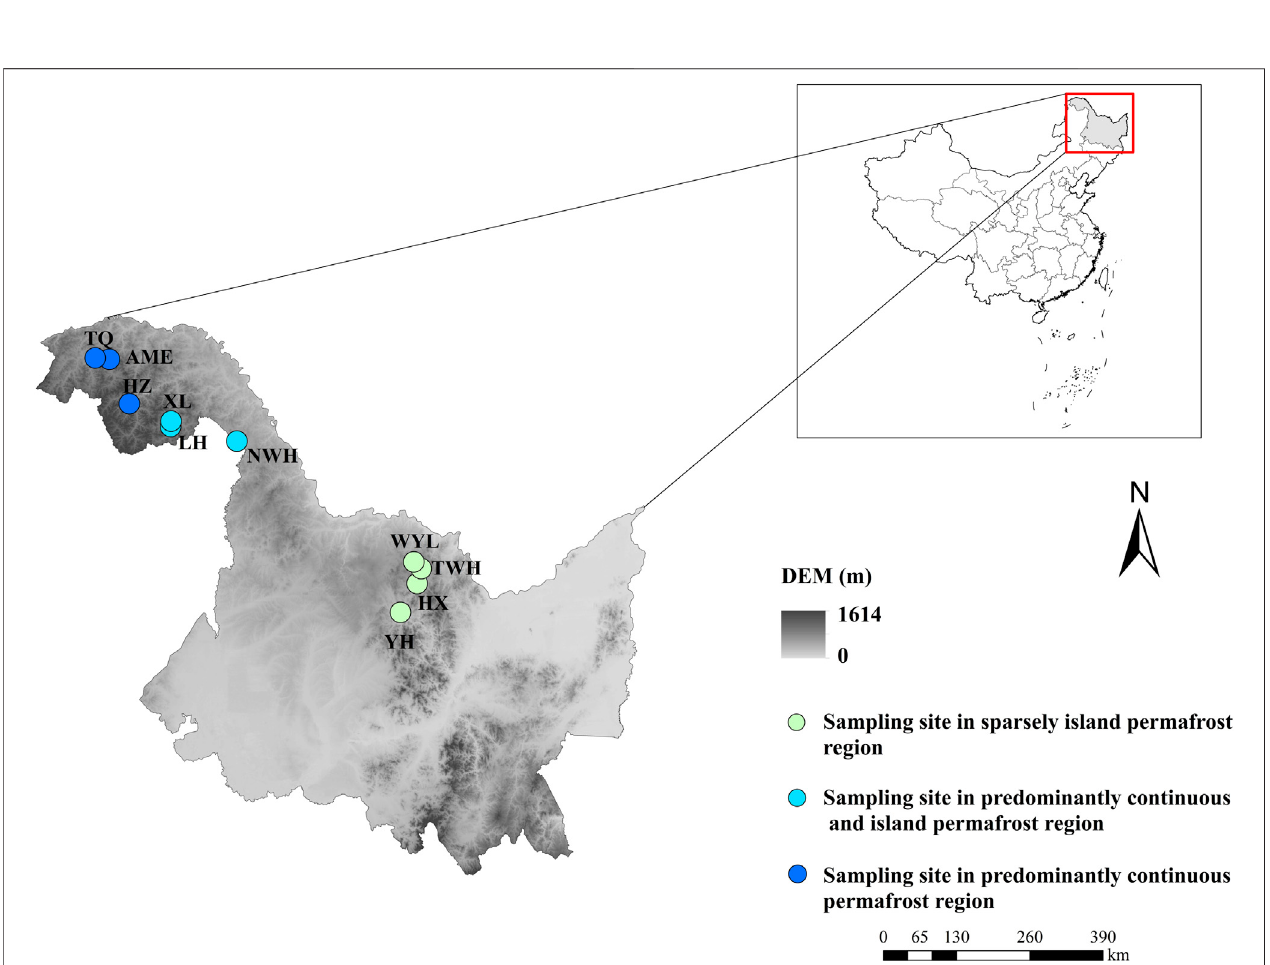
FIGURE 1 | Spatial arrangement of sampling sites in northeast China. YH: Youhao; HX: Hongxing; TWH: Tangwanghe; WYL: Wuyiling; NWH: Nanwenghe; LH: Linhai; XL: Xinlin; HZ: Huzhong; AME: Amuer; TQ: Tuqiang.